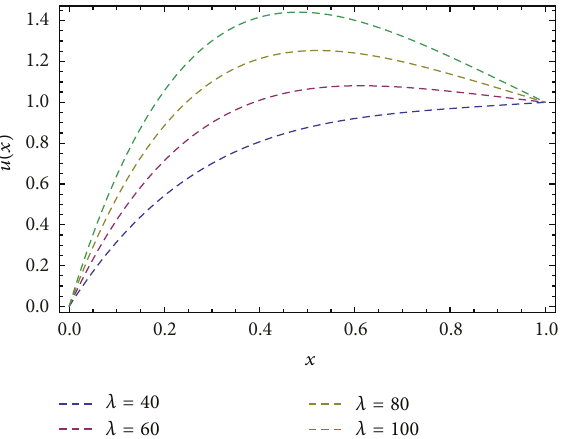
Figure 12: This figure shows the influence of the gravitational parameter 𝑚 on the velocity profile “ 𝑢(𝑥) ” for drainage problem keeping 𝛽 = 1 , 𝑀 = 1 , and Λ = 0.2 .